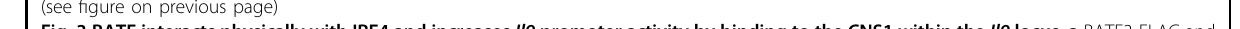
Fig. 3 BATF interacts physically with IRF4 and increases Il9 promoter activity by binding to the CNS1 within the Il9 locus. a BATF3-FLAG and IRF4 were expressed in HEK293T cells. Cell lysates were precipitated by an anti-FLAG antibody plus agarose or by a control IgG antibody. Precipitates were analyzed by immunoblotting (left), and the immunoblot was quanti fi ed by densitometry (right). b The CNSs of the Il9 locus. The numbers indicate the binding sites of the primers. c BATF3-binding sites within the CNSs of Il9 were analyzed in a ChIP assay. Control IgG and anti-FLAG antibodies were used for immunoprecipitation, and qPCR was performed for quanti fi cation. d Il9 promoter activity was measured in a transient reporter assay. EL4 cells were transfected with pCMV expression vectors. Cells were stimulated for 4 h with PMA and ionomycin, and were then analyzed in a luminometer. e Expression of Irf4 mRNA was measured by qRT-PCR under control or Batf3 -overexpressing conditions. Data were normalized to the levels of Gapdh and are shown relative to controls. f Naive CD4 + T cells from WT and Irf4 cKO mice were transduced with an empty or Batf3 overexpression vector. The cells were stimulated under Th9 conditions for 3 days. Transduced cells were gated for GFP, and then IL-9 production was measured by fl ow cytometry. OX, overexpression. g Diagram of the IAD domain deletion mutant of IRF4. h Il9 promoter activity was measured by a transient reporter assay. EL4 cells were transfected with CMV vectors expressing the indicated transcription factors and were then stimulated with PMA and ionomycin for 4 h. Error bars represent the s.d. P values were calculated using Student ’ s t -tests. * P < 0.05, ** P < 0.01, and *** P < 0.001. All experiments were repeated independently three times.